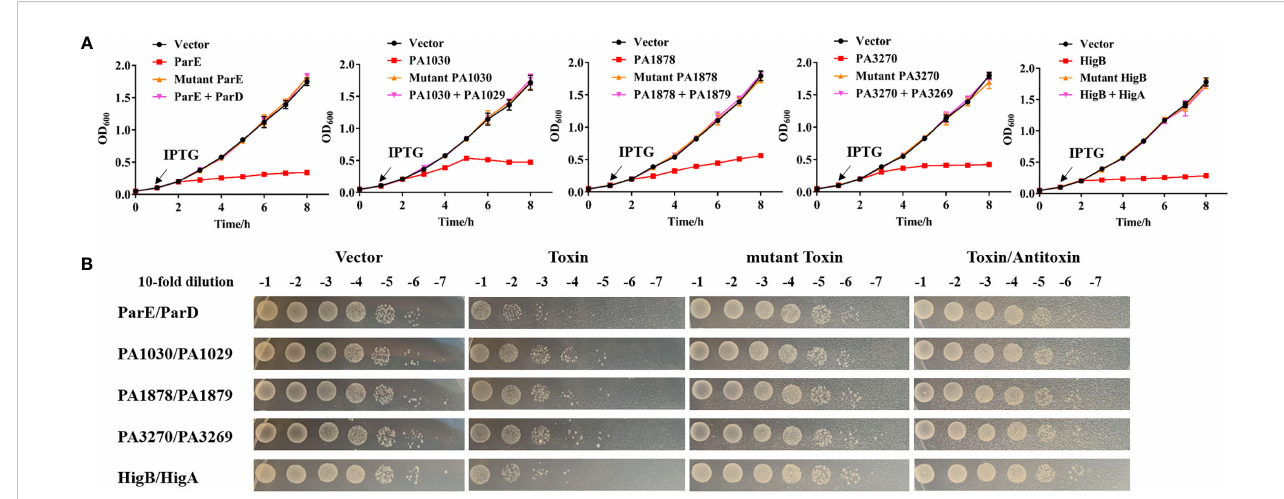
FIGURE 3 Toxicity assays of toxins and their cognate antitoxins. (A) Expression of the toxin causes notable growth arrest of E coli , and the cognate antitoxin can neutralize the toxic effects. Overnight cultures of E coli BL21 (DE3) harboring pRSFDuet-1 -based plasmids with toxin, antitoxin or mutant toxin genes were reinoculated into fresh LB at OD 600 = 0.05. After 1 h, the cultures were added by 0.1 mM IPTG and continued to cultivate at 37°C for growth detection. (B) After 8 h growth in (A) , the cultures were also serially diluted and spotted on LB plates at 37°C for 16 h before colony counting. The detailed mutations about toxins are ParE (T62/A, T64/A, S71/A, V89/A), PA1030 (R82/A, E104/A, S184/A), PA1878 (H39/A, H69/A, D70/A), PA3270 (G108/A, T100/A), HigB (H92/A) referring to the key resides of toxins in Figure 2. The experiments were repeated three